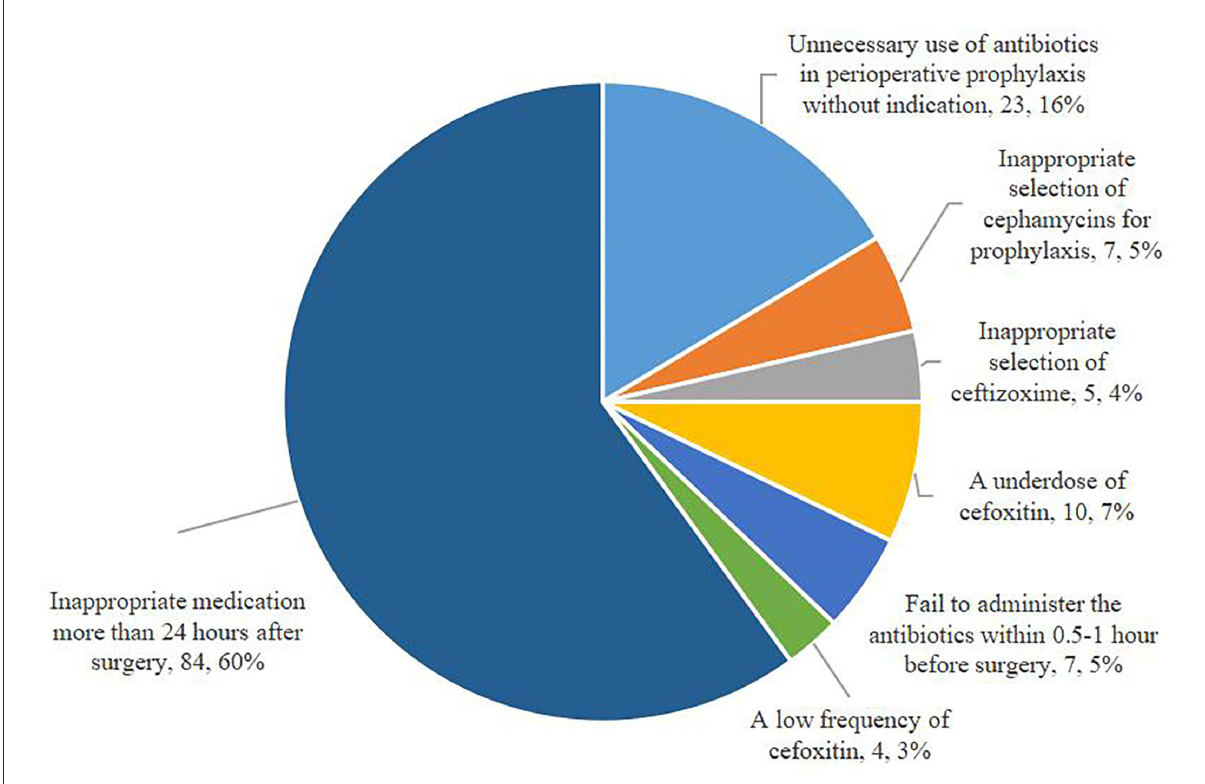
FIGURE3 Inappropriate perioperative antimicrobial prophylaxis in the hepatobiliary surgery